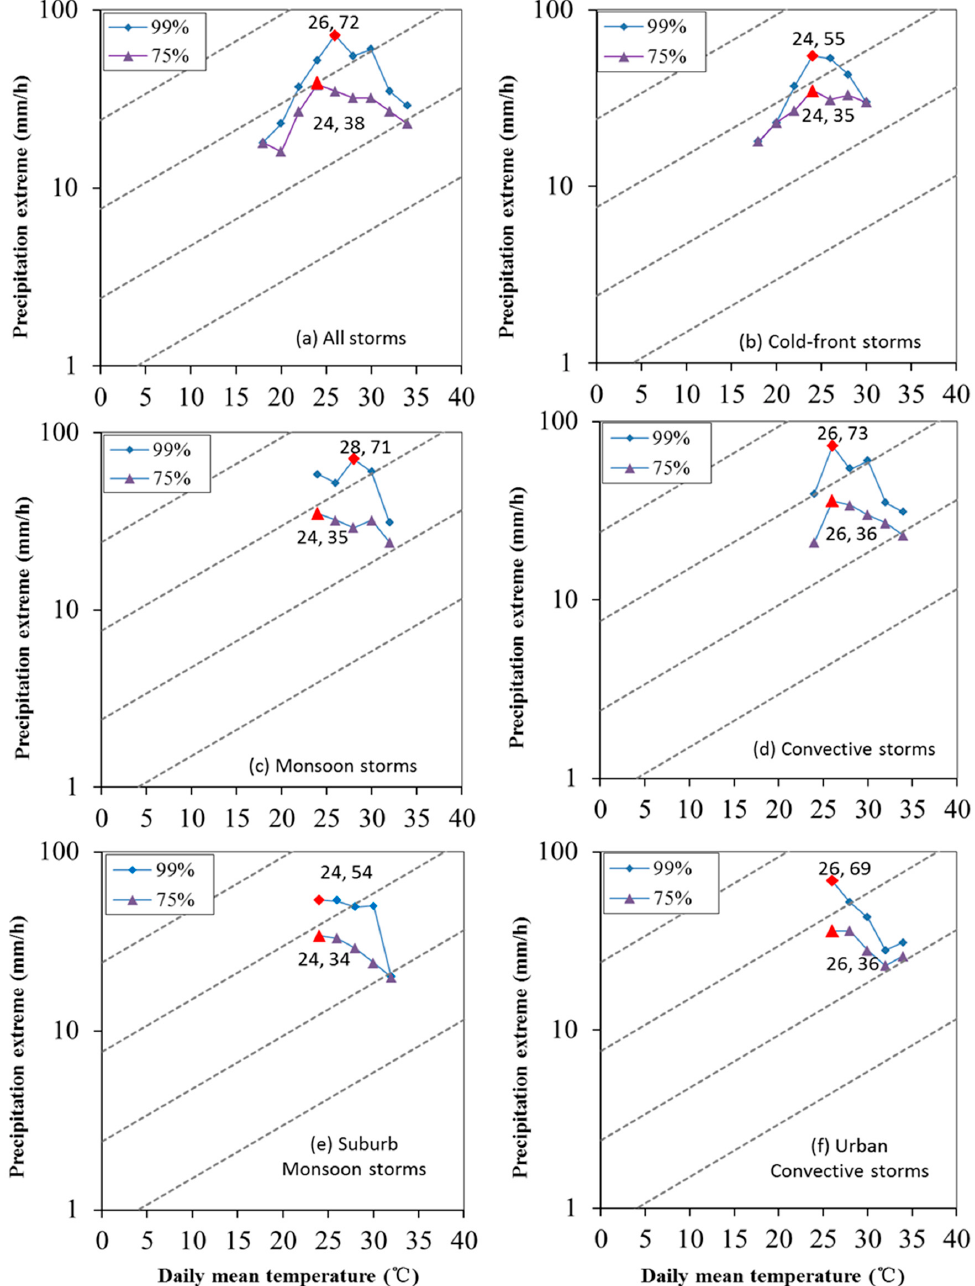
Figure 11. The same as Figure 10, but using the natural daily mean air temperature. The peak-like structure of the scaling rates between the precipitation extremes and air temperature revealed in this study are similar to those reported in the literature [13,14,16,17], but are slightly different from those who found negative scaling rates in the tropic and subtropical regions when daily mean air temperature was above 25 °C, such as in Brazil [15], Northern Australia [19], Southern China [20], and Hong Kong [24]. Such negative scaling rates were also identified by using